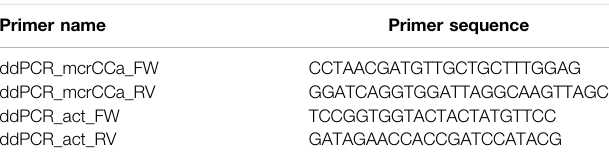
TABLE 2 | Oligonucleotides used for gene copy number determination analysis with ddPCR. Primer